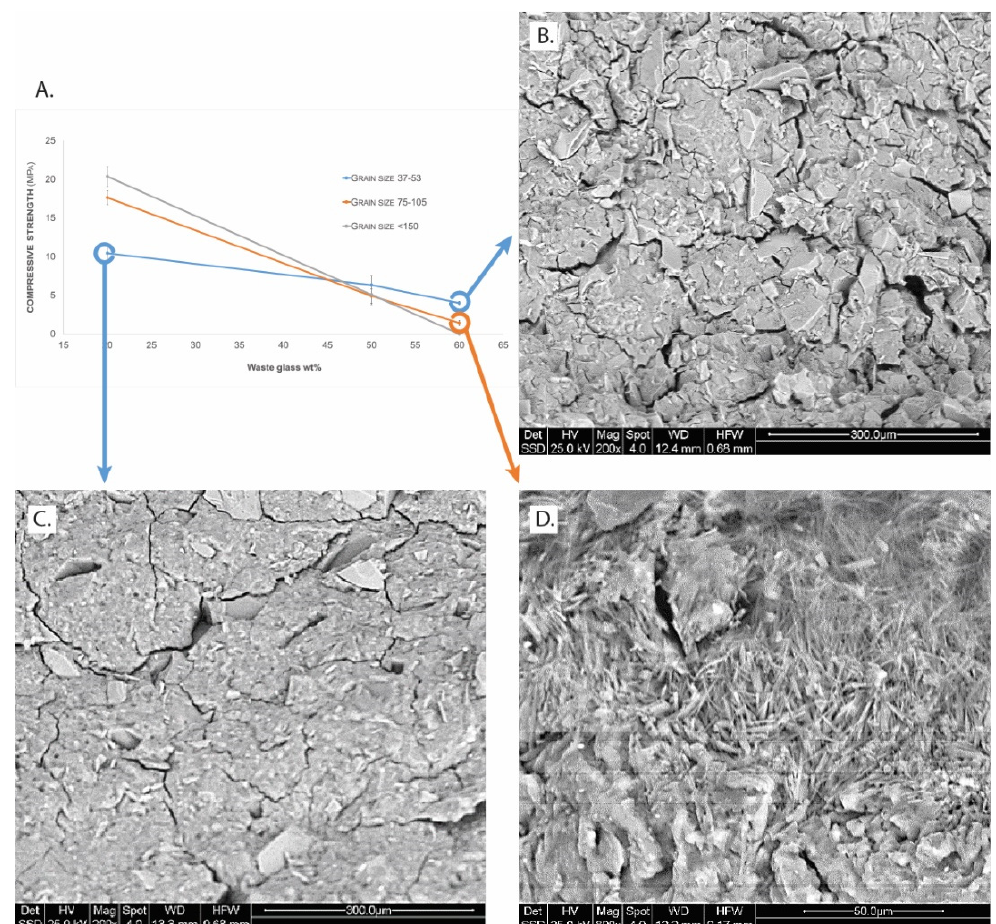
Figure 6. ( A ) Compressive strength for all the samples aged 28 days (lines are drawn for eye help only). SEM observation of fresh fractured surfaces from samples with finer grain size: 37–53 μ m ( B ) GP/WG 60%, ( C ) GP/WG 20% (BSE, 800 × ), ( D ) GP/WG 60% with coarse gain size (BSE 800 ×